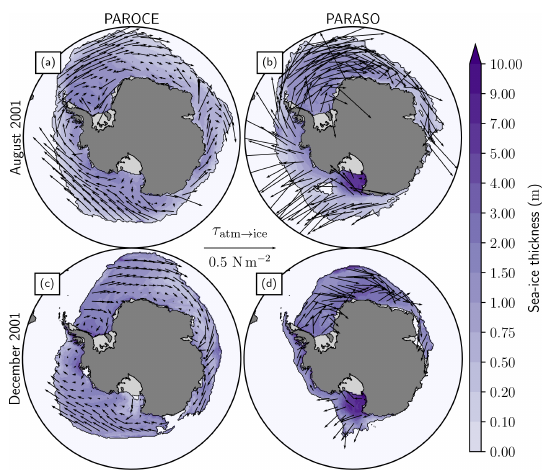
Figure A7. Sea-ice thickness (color map) and air–sea-ice wind stress (arrows) in (a, b) August and (c, d) December of 2001 (second simulated year), for (a, c) PAROCE and (b, d) PARASO. Sea-ice thicknesses are only drawn on areas with sea-ice concentrations exceeding 15%. While the wind stress scale is linear, note that the sea-ice thickness scale is